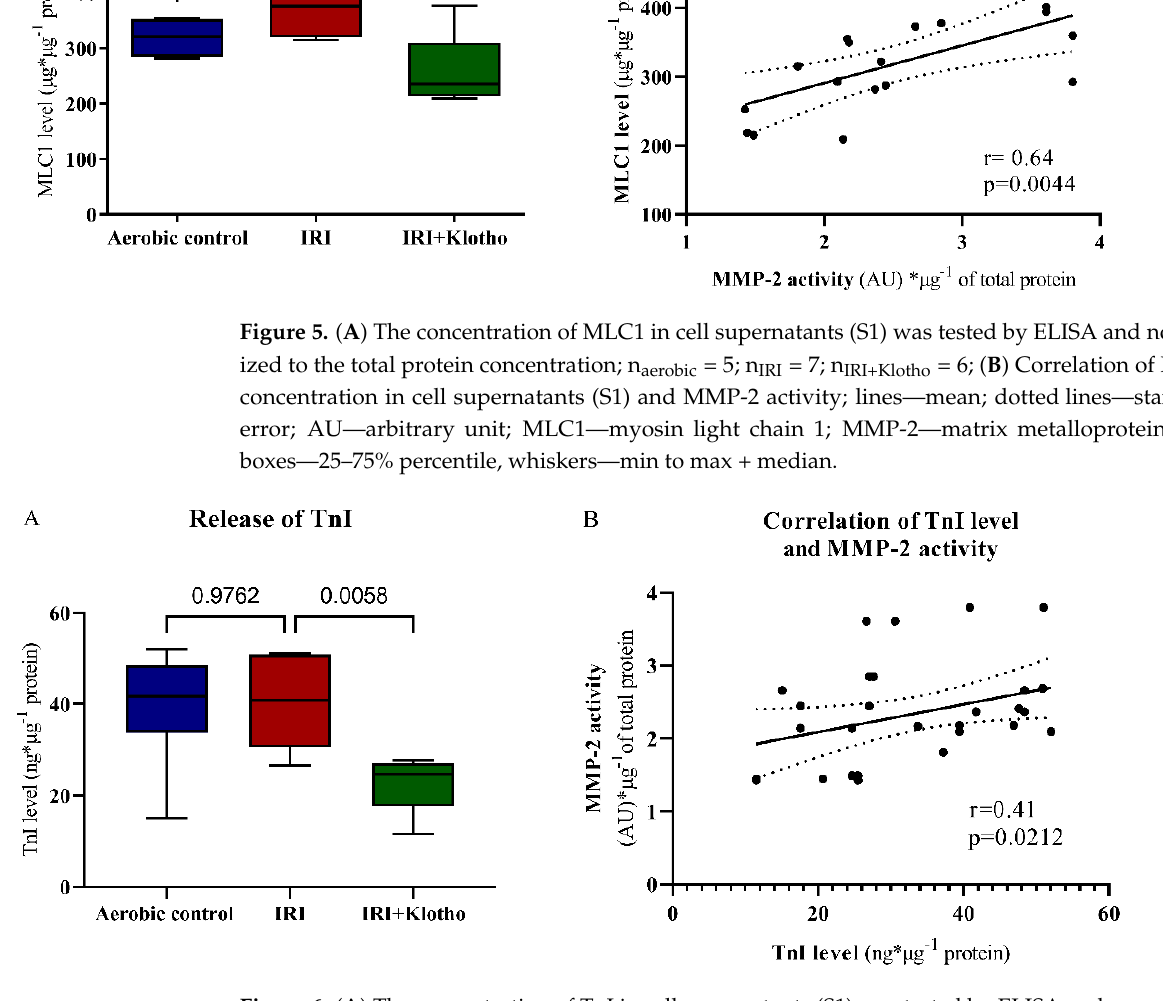
Figure 6. ( A ) The concentration of TnI in cell supernatants (S1) was tested by ELISA and normalized